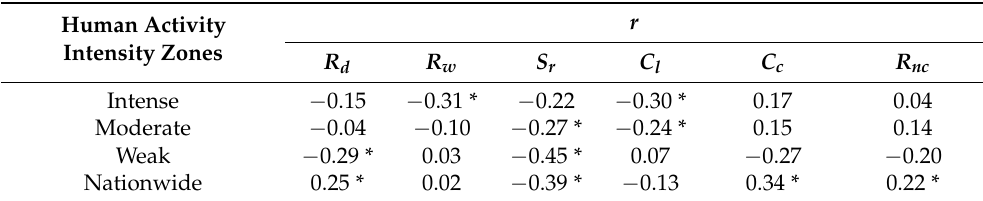
Table 5. Pearson correlation coefficient ( r ) between WER and SCCs in different human activity intensity zones.